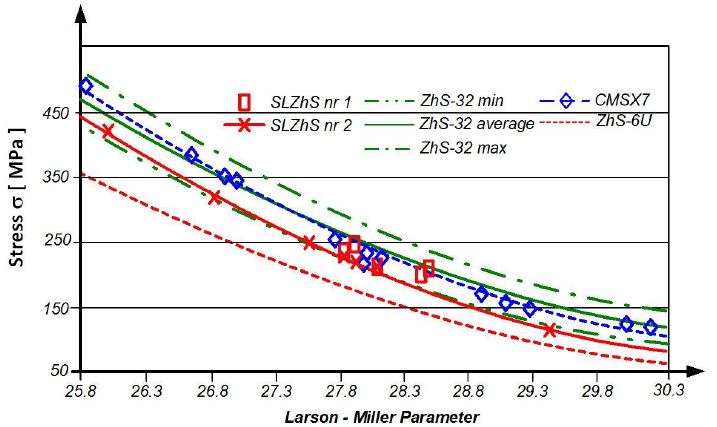
Figure 3. Influence of temperature and exploitation time on the exploitation stress of ZhS alloys used in the construction of RD-33 engine turbine blades, as defined by the Larson–Miller parameter P [3].